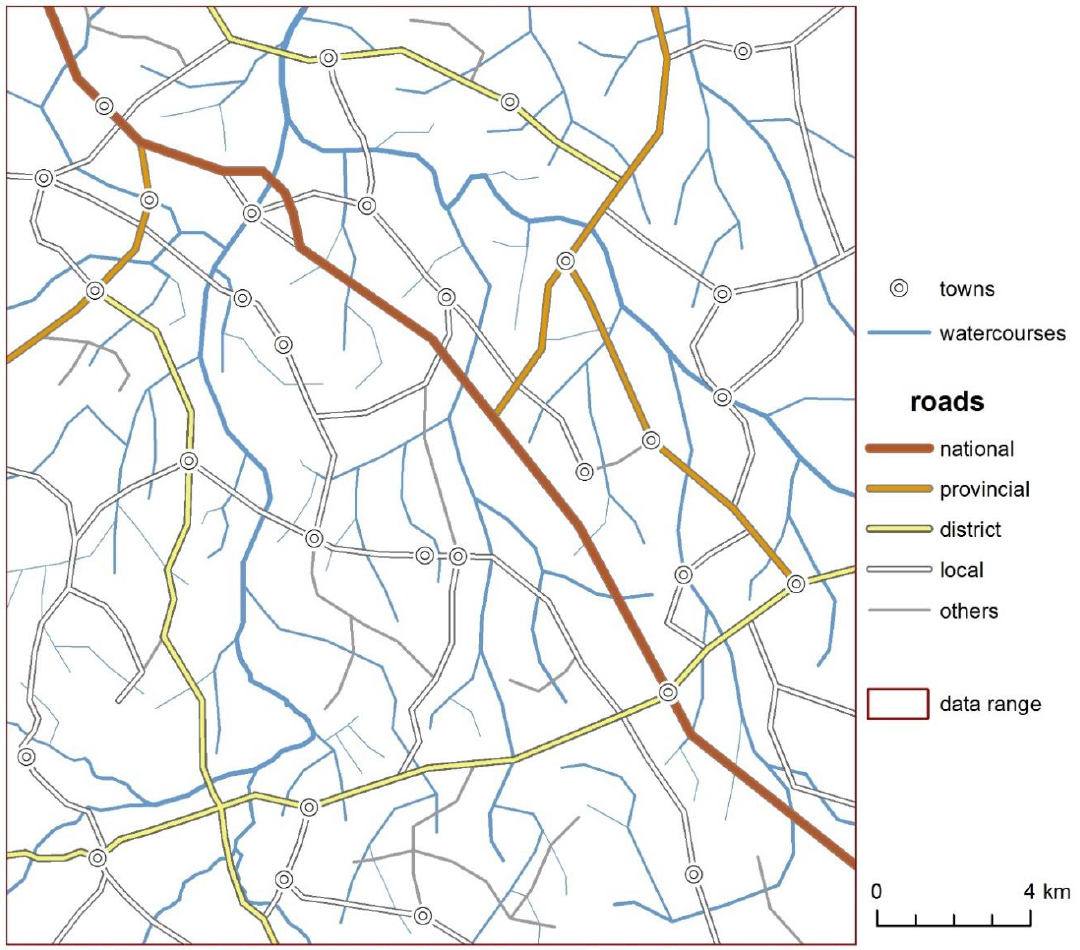
Figure 3. Model data in the area B shown in Figure 1 (viewed in ArcMap ESRI); source: own work.